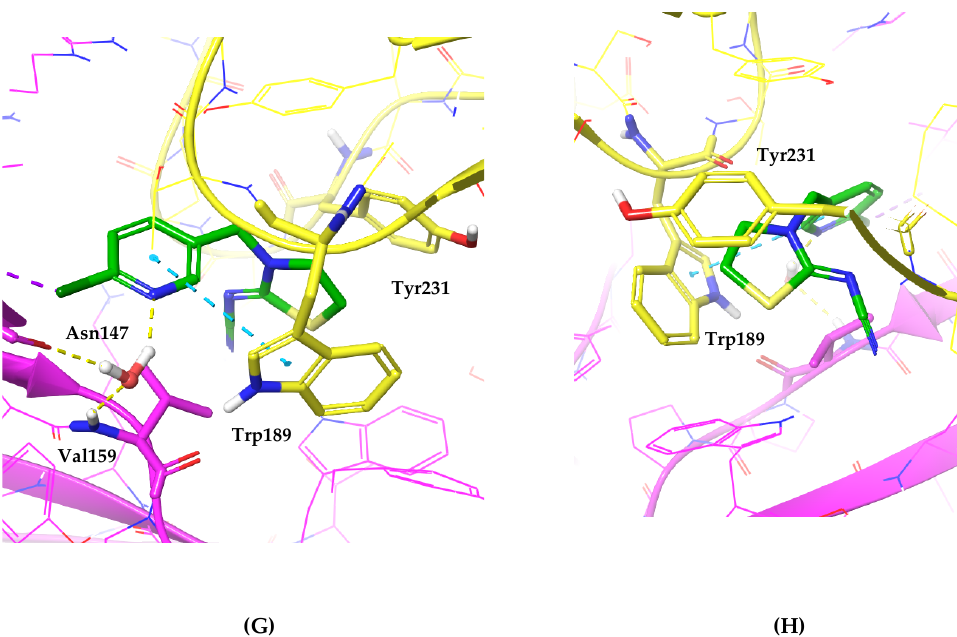
Figure 7. Predicted binding modes of IMI and THI with the cockroach Pame α 7 receptor viewed according to four orientations: from the top of the homomeric pentameric nAChR ( top of the A , B ); from the side of the C and D subunits ( C , D ); with the pyridinic ring ( left : E , G ) and the push-pull fragment ( right : F , H ), in the plane of the figure, respectively. The docking scores and glide energies computed were − 7.2 and − 75.1 kcal/mol for IMI and − 4.6 and − 71.7 kcal/mol for THI, respectively. For clarity, the labelling of the key amino acids involved in intermolecular interactions with the two ligands have been added to ( E – G ), with these amino acids being represented as ball-and-stick models. For the same reasons, only the polar hydrogen atoms are represented. Tyr: tyrosine, Trp: tryptophan, Val: valine, Asn: asparagine, Lys: